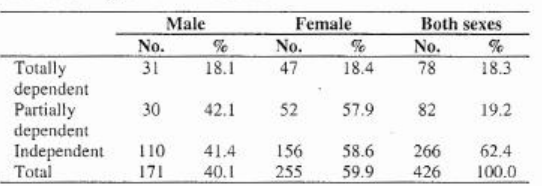
‘Table 3. Distribution of respondents by